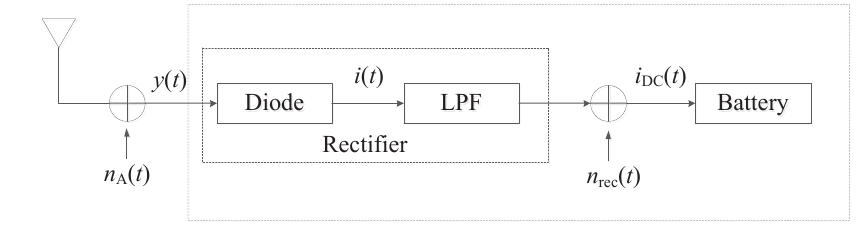
Figure 2. Energy collecting model. Table 1. Variables and their